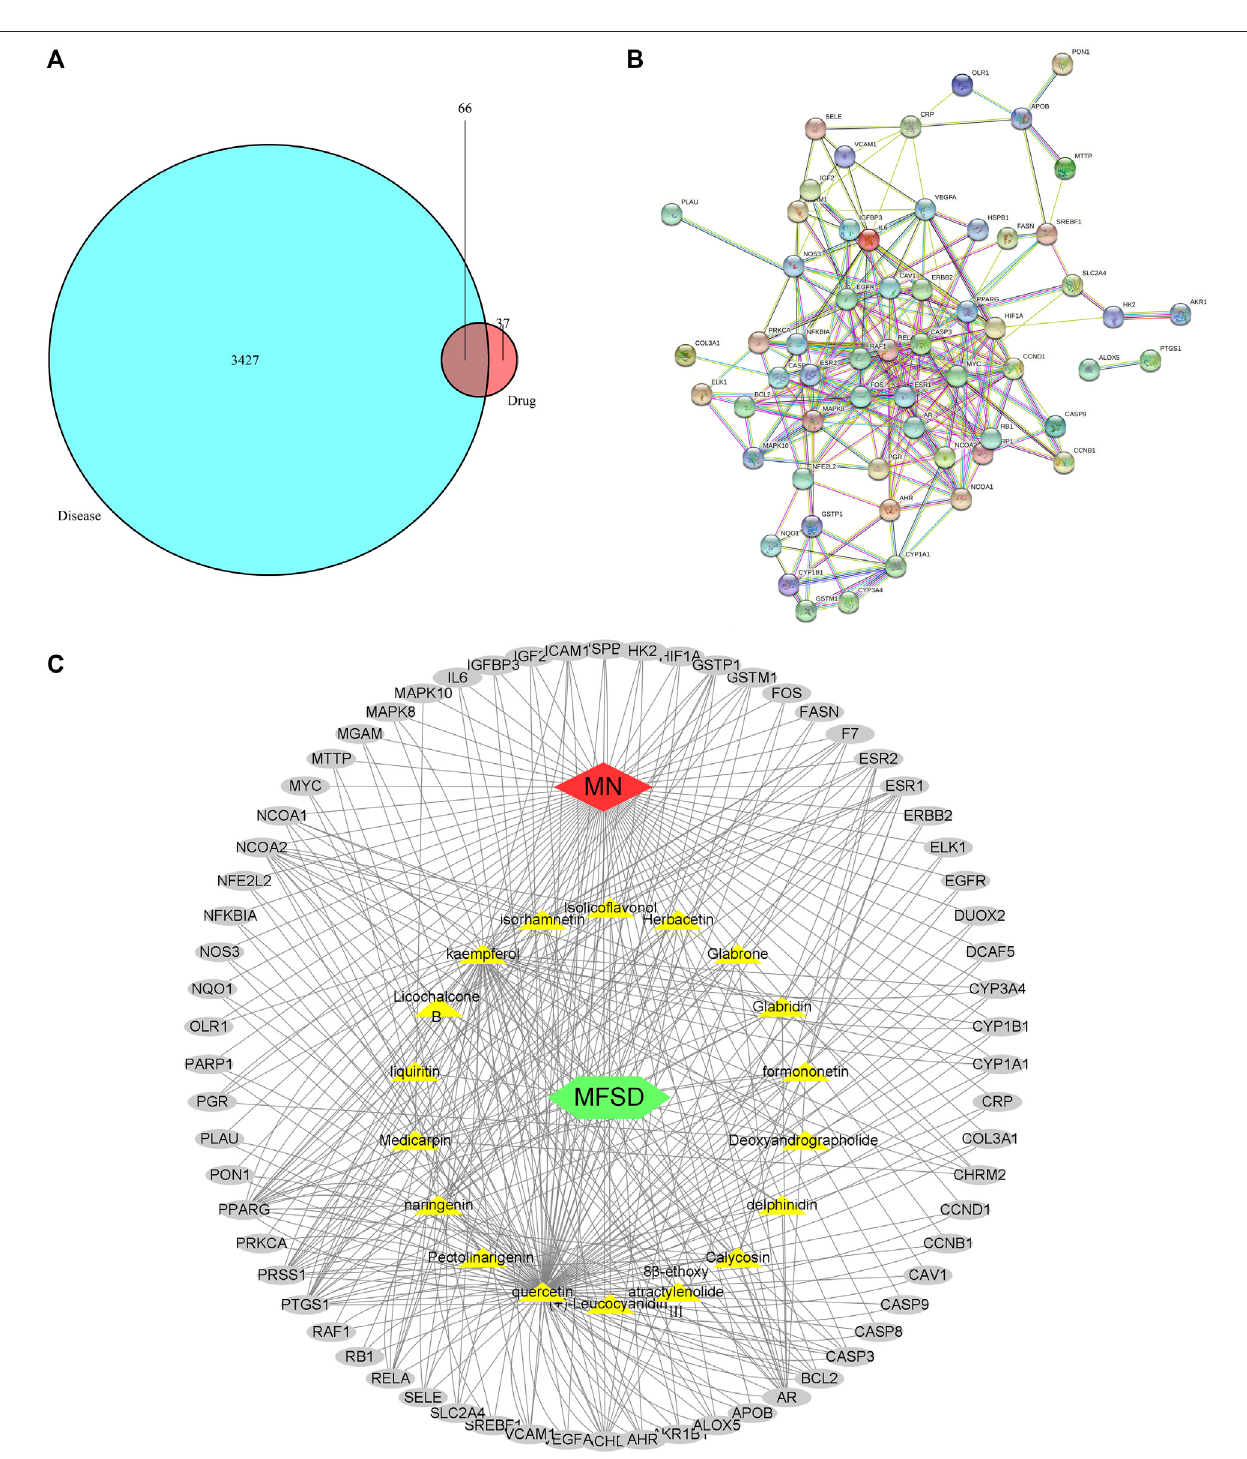
FIGURE4| Active compound ofMFSDtarget MNand protein – protein interaction (PPI) networkanalysis (A) Venn diagram ofdrug-diseasetargets. The cyancircle represents3,427known therapeutic targets forthetreatment ofMN.The redcircle represents103known drugtargets ofMFSD.Intotal, 66shared targets wereshown between MFSD and MN. (B) The PPI analysis of 66 overlapping targets of MFSD and MN. The nodes get larger with an increasing degree. Edges: PPI between shared targetsandtheirinteractivepartners (C) PotentialCompound-Targets-Pathway(pC-T-P)networkofMFSDinthetreatmentofMN.Therewere6kindsofherbs,18 compounds, 66 predicted targets. The yellow hexagon represents 6 kinds of herbs in MFSD, while the grey circle represents potential targets. (For interpretation of the references to color in this fi gure legend, please refer to the Web version of this article.)